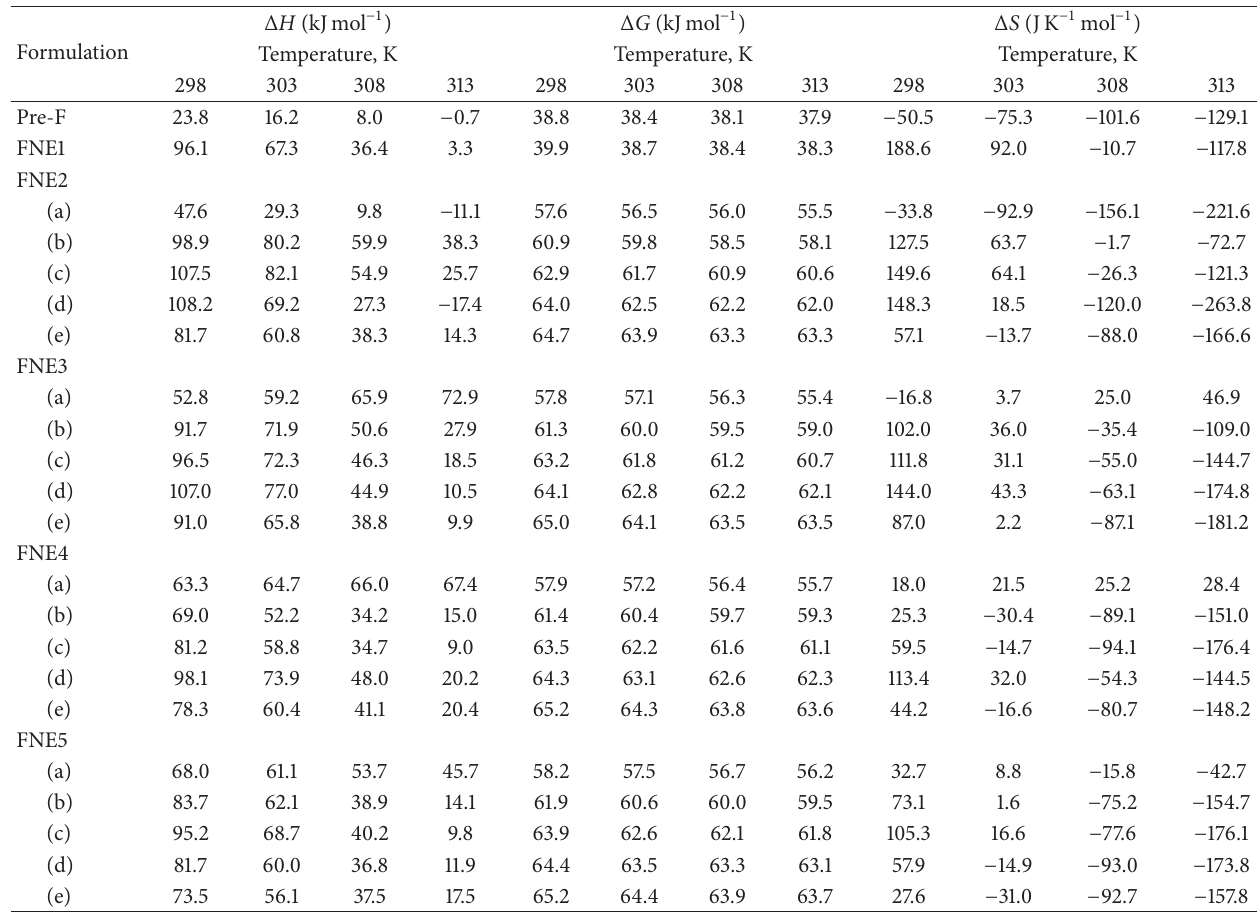
Table 5: Temperature-dependent activation parameter for PKOEs/Tween 80 : Span 80/water systems.